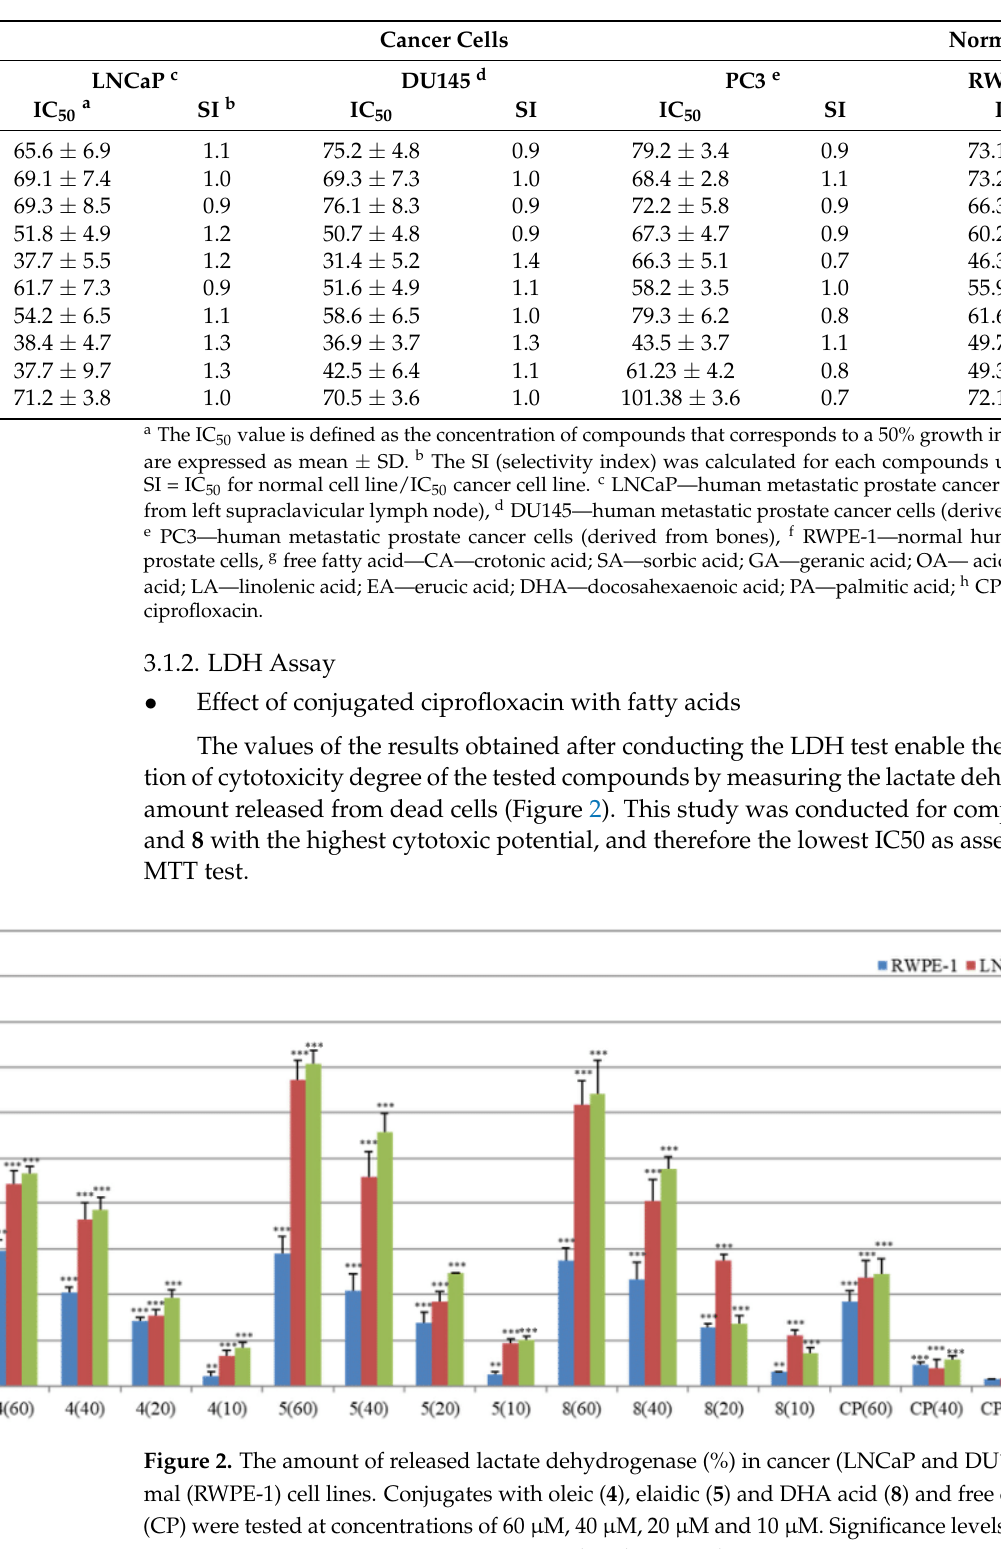
Table 3. The IC50 and SI values of the tested unconjugated ciprofloxacin and individual fatty acids.